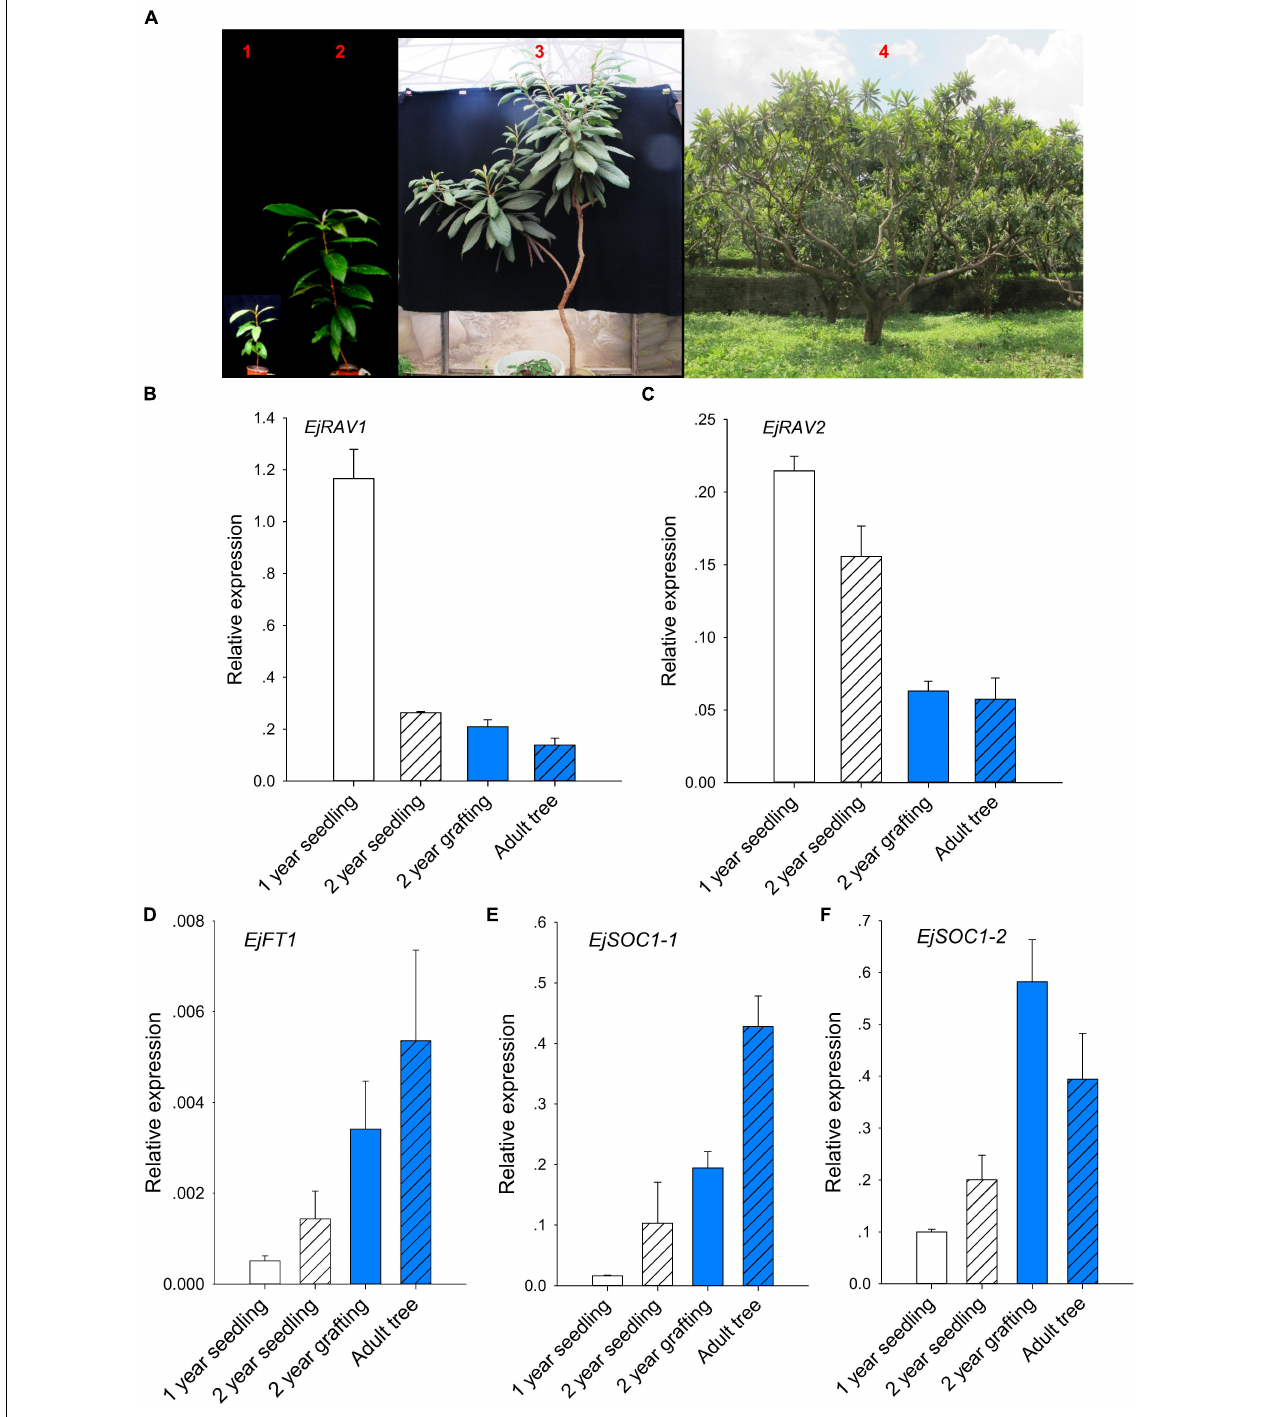
FIGURE 3 | Association of abundant EjRAVs expressions and rare flowering activator gene expressions with the juvenile phase. (A) “Zaozhong-6” plants at different developmental stages in July, 2018. The red numbers, 1–4, in A showed plants of a 1-year-old seedling, a 2-year-old seedling, a 2-year-old grafted tree and an adult fruit-bearing tree used for gene expression assays, respectively. ( B–F ) Expression patterns of EjRAV1 (B) , EjRAV2 (C) , EjFT1 (D) , EjSOC1-1 (E) , and EjSOC1-2 (F) in mature leaves of these trees. The expression level of EjFT2 was almost undetectable in all the trees and data were not shown. The error bars in (B–F) represent standard deviation for three biological